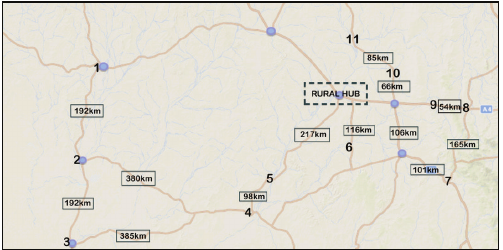
Figure 1: Remote communities visited by the RODRS program (listed 1 to